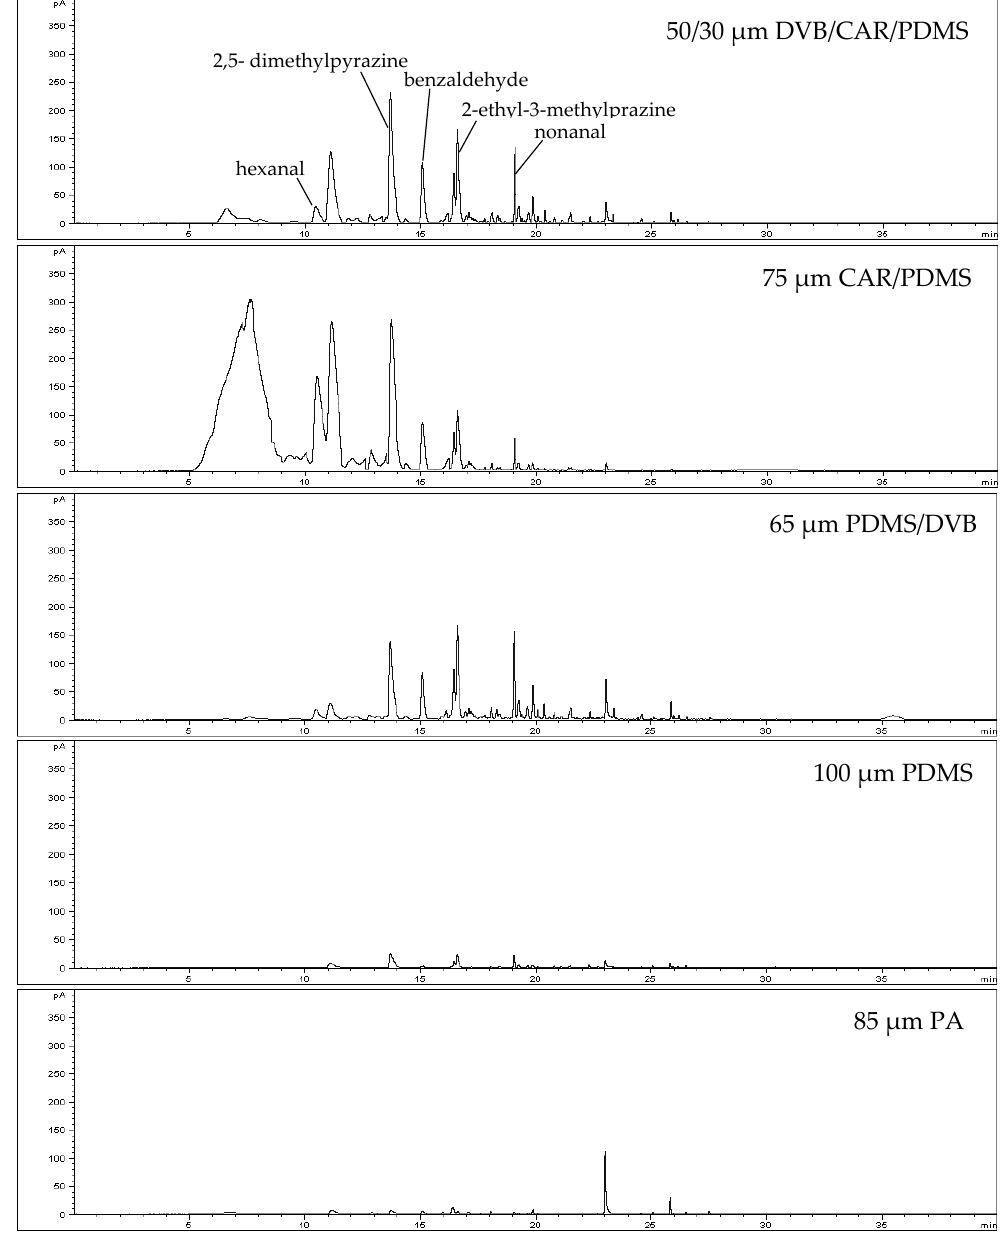
Figure 1. Gas chromatograms of Hekei-140 volatile components using different absorption fibers in combination with HS-SPME.